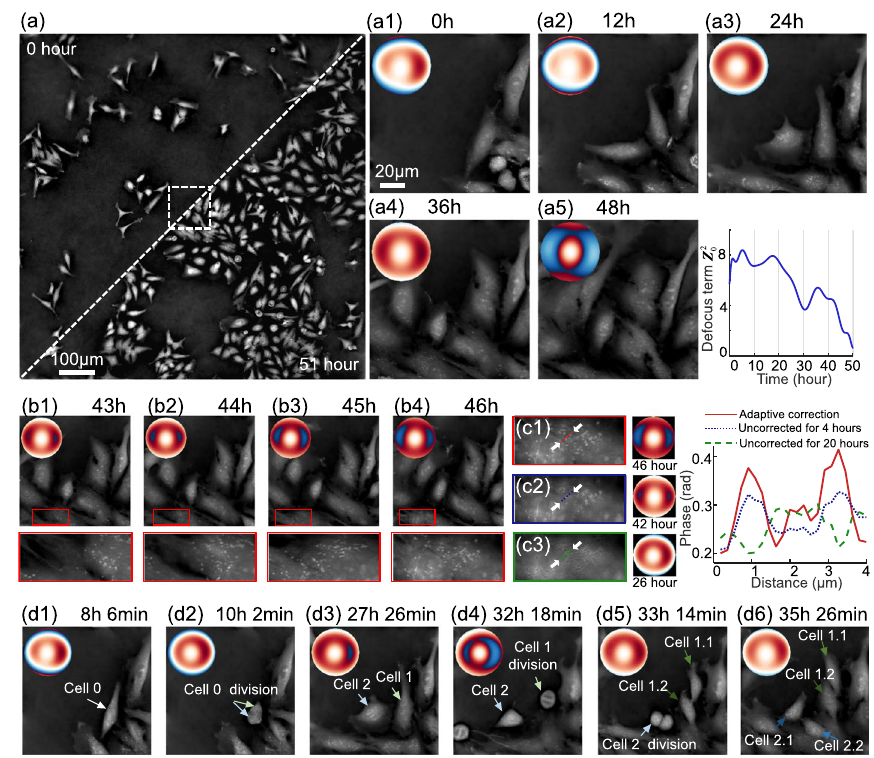
Fig. 5 Long-term live-cell phase imaging across 51 hours [see Visualization 2]. (a) The Full-FOV phase maps of the first and last frame in the movie. (a1)-(a5) The zoomed-in phase maps in the central region of (a) as well as the line chart indicating the out-of-focus distance variation over the 51 hours. (b1)-(b4) Dynamic high-resolution demonstration of cellular architecture across 4 hours. (c1)-(c3) Comparison of results with and without adaptive aberration correction as well as the profiles of the cell phase. (d1)-(d6) The 3-generation cell division process from 8h 6min to 35h